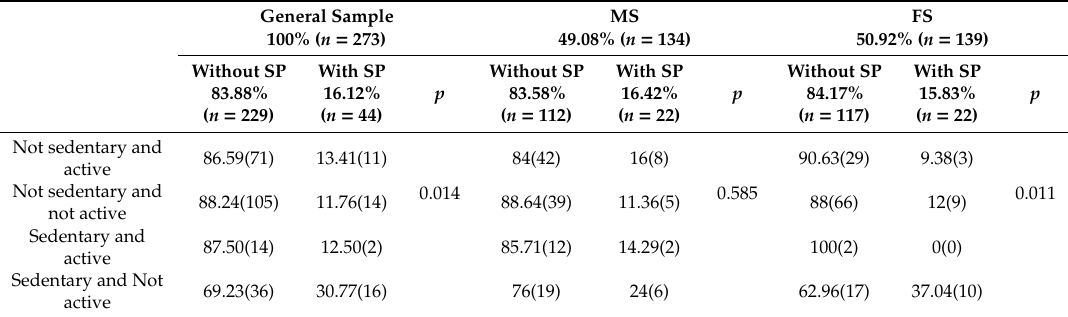
Table 5. Percentages (counts) of sedentary and active behaviors variable and di ff erences between SP and